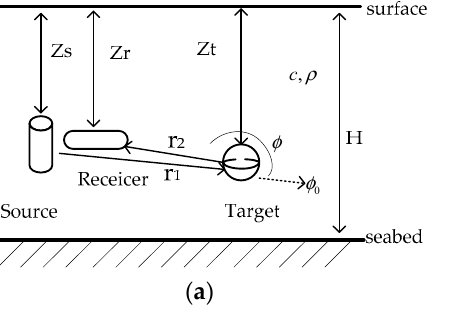
Figure 1. Front view of the relative positional relationship: ( a ) monostatic configuration; ( b ) bistatic